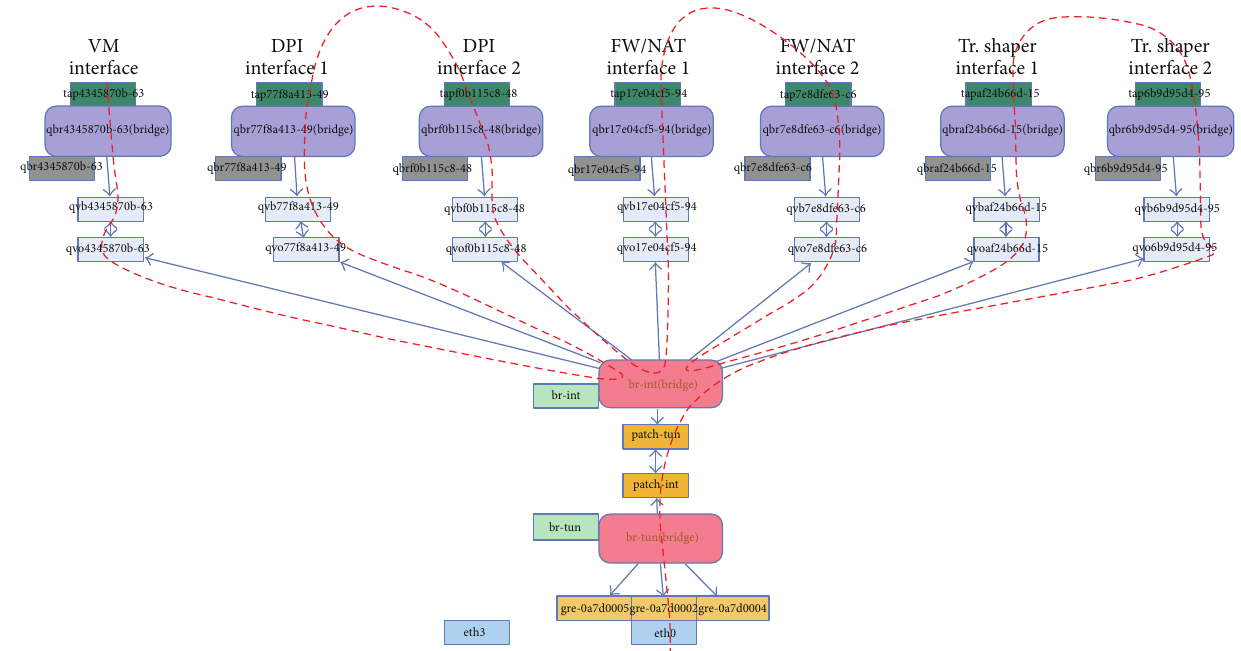
Figure 8: A view of the OpenStack compute node with the tenant VM and the VNFs installed including the building blocks of the virtual network infrastructure. The red dashed line shows the path followed by the packets traversing the VNF chain displayed in Figure 7(d).